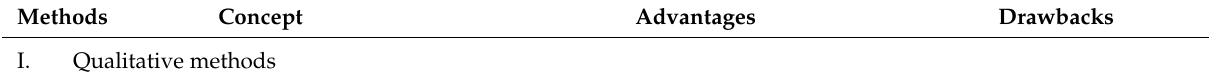
Table 3. Experimental methods for determination the carbonation degree: Content, pros and